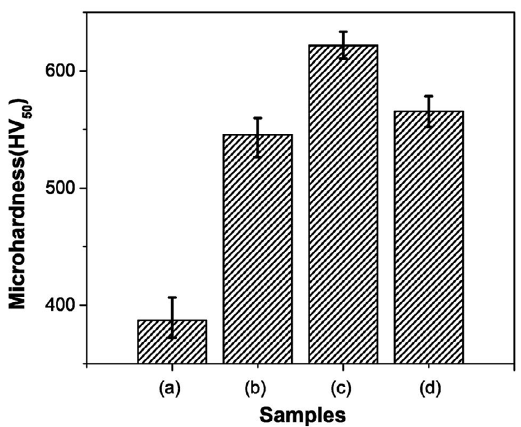
Figure 5. Microhardness of (a) Ni-P; (b) Ni-P/Ni-P; (c) Ni-P- 12.5mL/L TiO /Ni-P; (d) Ni-P-50mL/L TiO 2